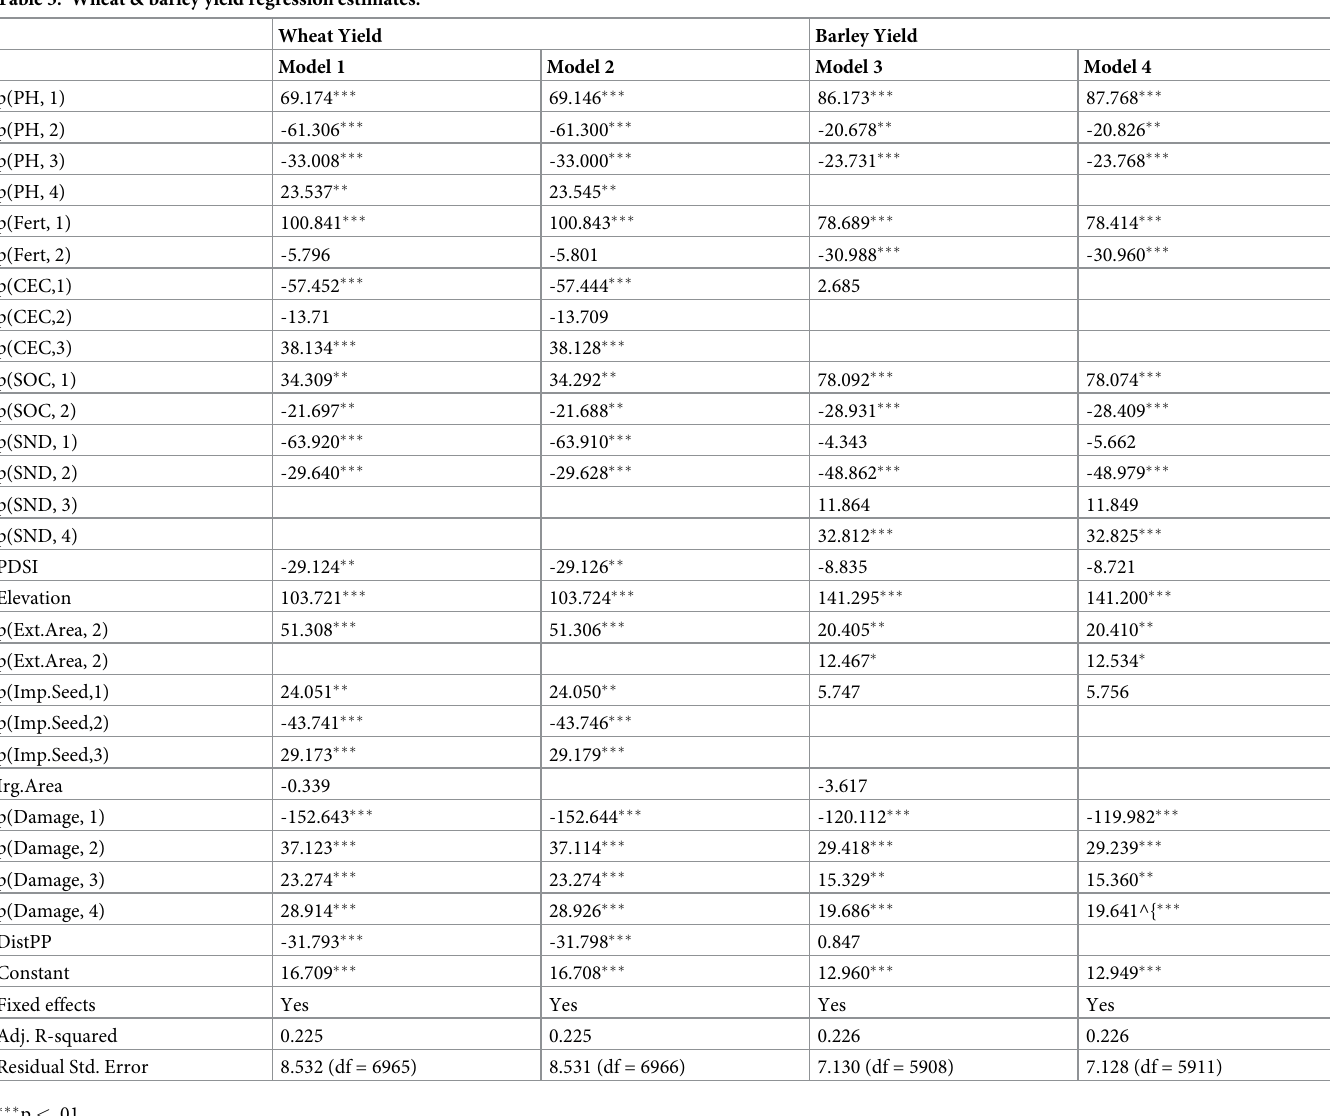
Table 3. Wheat & barley yield regression